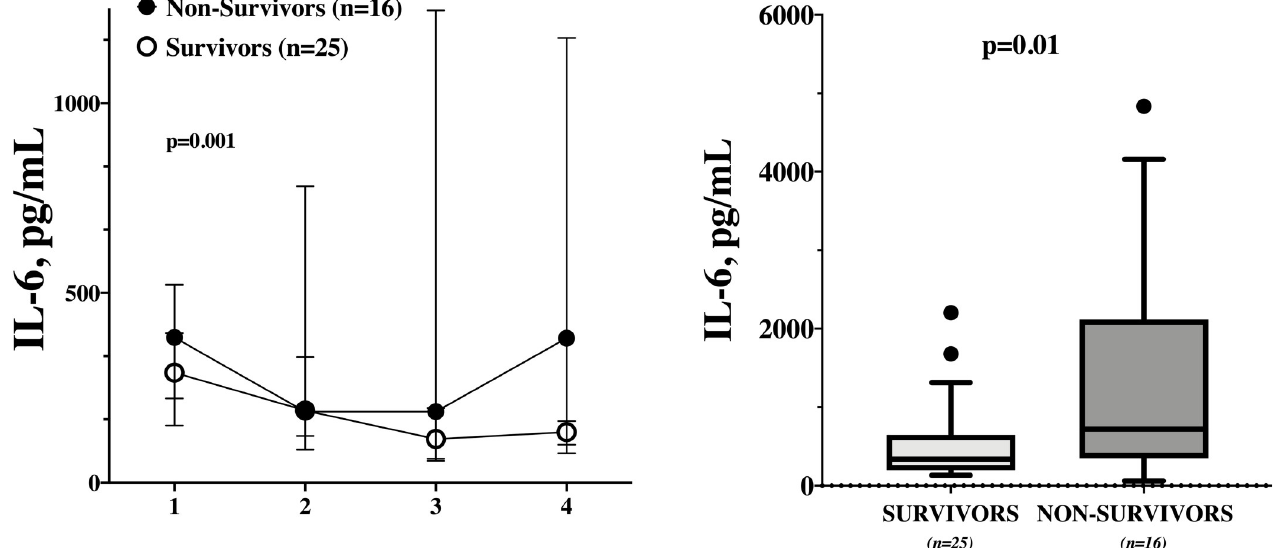
Fig 1. IL-6 values over time in survivors and non-survivors (LEFT); differences in the highest IL-6 value in survivors and non-survivors (RIGHT).